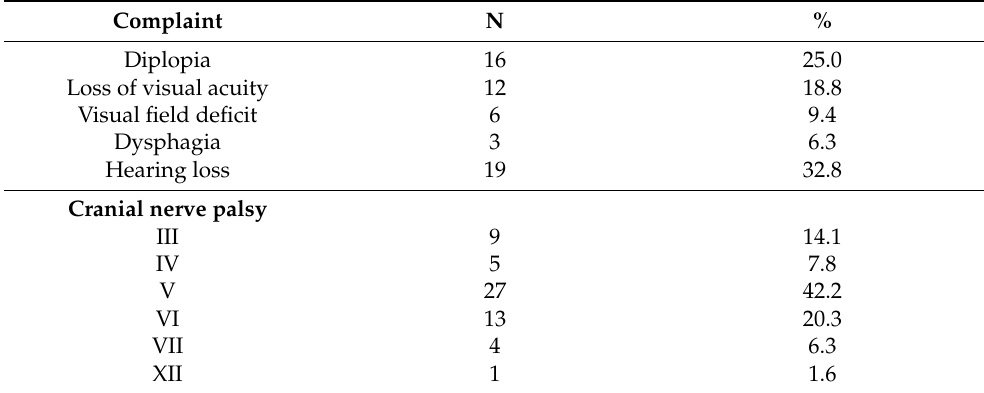
Table 3. Numbers of cases with preoperative subjective complaints and cranial nerve palsies. N, number; %, percentage of entire cohort (64).